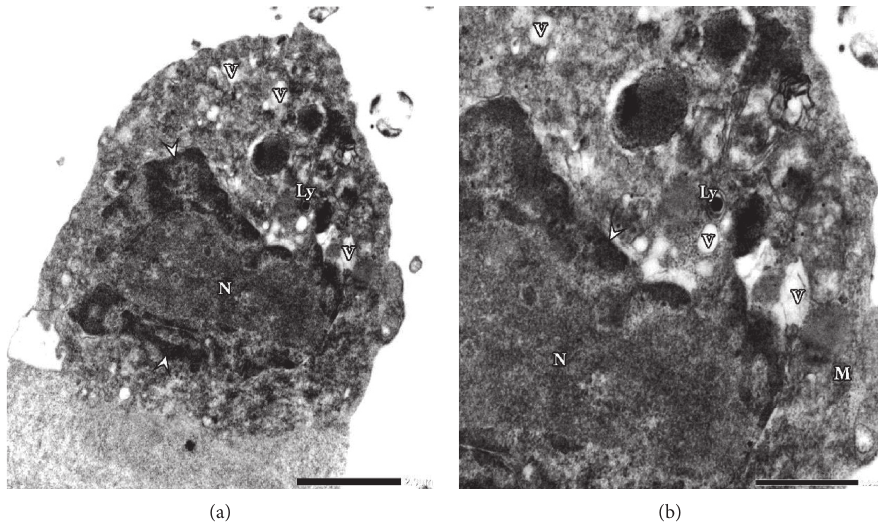
Figure 7: (a) Electron micrograph of glyphosate-treated cells (0.0025 mM) illustrates irregular nuclear membrane with highly migrated chromatin (head arrow) and lack of nuclei (Nu). Rough endoplasmic reticulum (RER), high distributed vacuoles (V), and some autolysomes (Ly) were noted (F 4 G 1 -OsO 4 fixed-uranyl acetate lead citrate stained preparation, 4000x). (b) High magnification at 8000x shows compacted organelles and a lack of